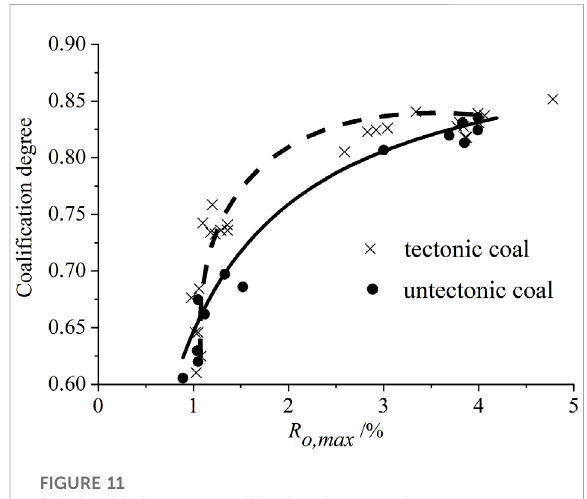
FIGURE 11 Relationship between coali fi cation degree and